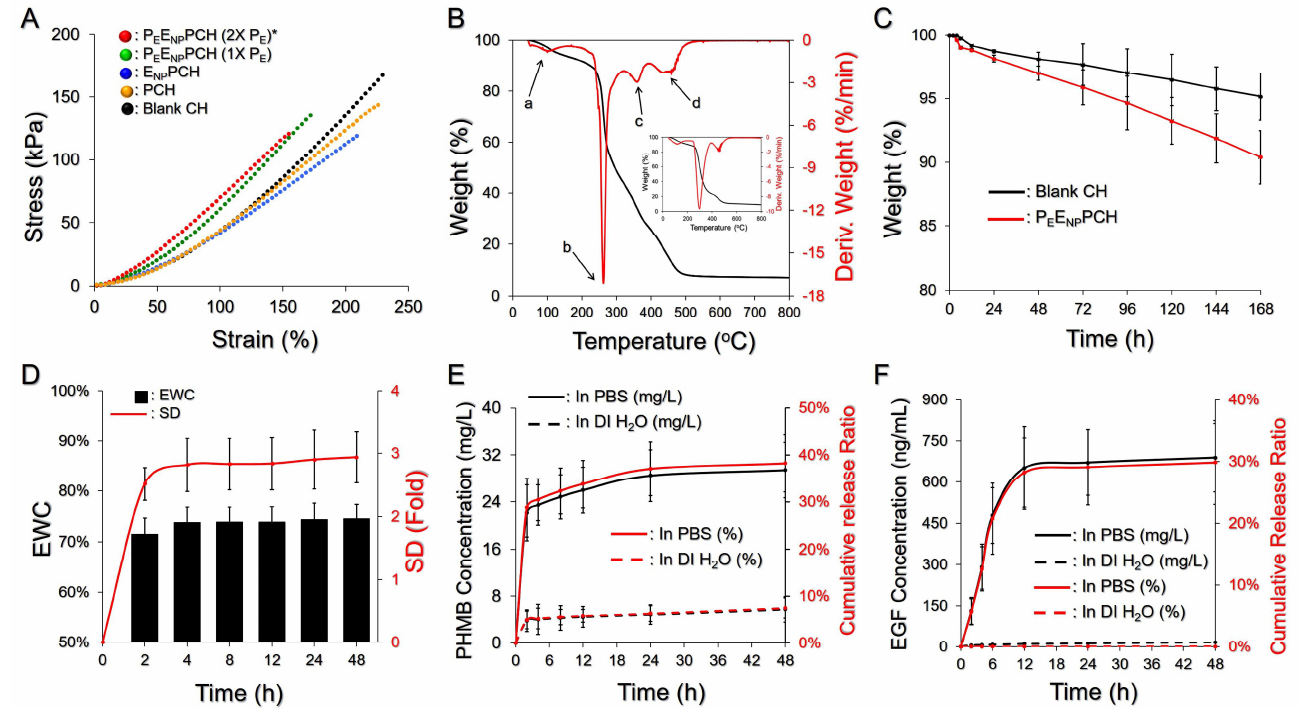
Figure 2. Assessment of the physicochemical properties of P E E NP PCH. ( A ) Stress vs. strain curves of the four hydrogels indicated in the figure. The doses of EGF and PHMB in the three hetero-composite hydrogels were equally set to 60 µ g/mL and 2000 ppm, respectively. * 2X PEs denotes that the dose of PE-trapped PFOB in the hydrogel was 50 mg/mL. ( B ) TGA and DTG curves of the P E E NP PCH at temperatures ranging from 50–800 ◦ C were obtained at a heating rate of 10 ◦ C/min under a nitrogen atmosphere. The inset image represents the TGA and DTG curves of the blank CH. ( C ) Degradation profiles of the P E E NP PCH (red) and the blank CH (black) in 37 ◦ C PBS within 7 days. ( D ) The swelling profile (red) and the EWC (black) of the P E E NP PCH in 37 ◦ C PBS within 48 h. ( E , F ) In vitro kinetic drug release profiles of PHMB ( E ) and EGF ( F ) from the P E E NP PCH incubated in PBS or DI water at 37 ◦ C within 48 h. The cumulative released amount and ratio for each drug are presented in black and red curves, respectively, as indicated in the figure. Values in ( C – F ) are presented as mean ± s.d. (n = 3).